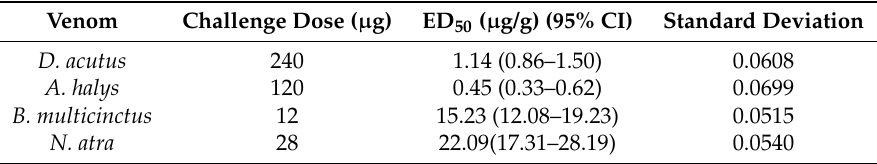
Table 1. The ED 50 of varespladib against challenge of four snake